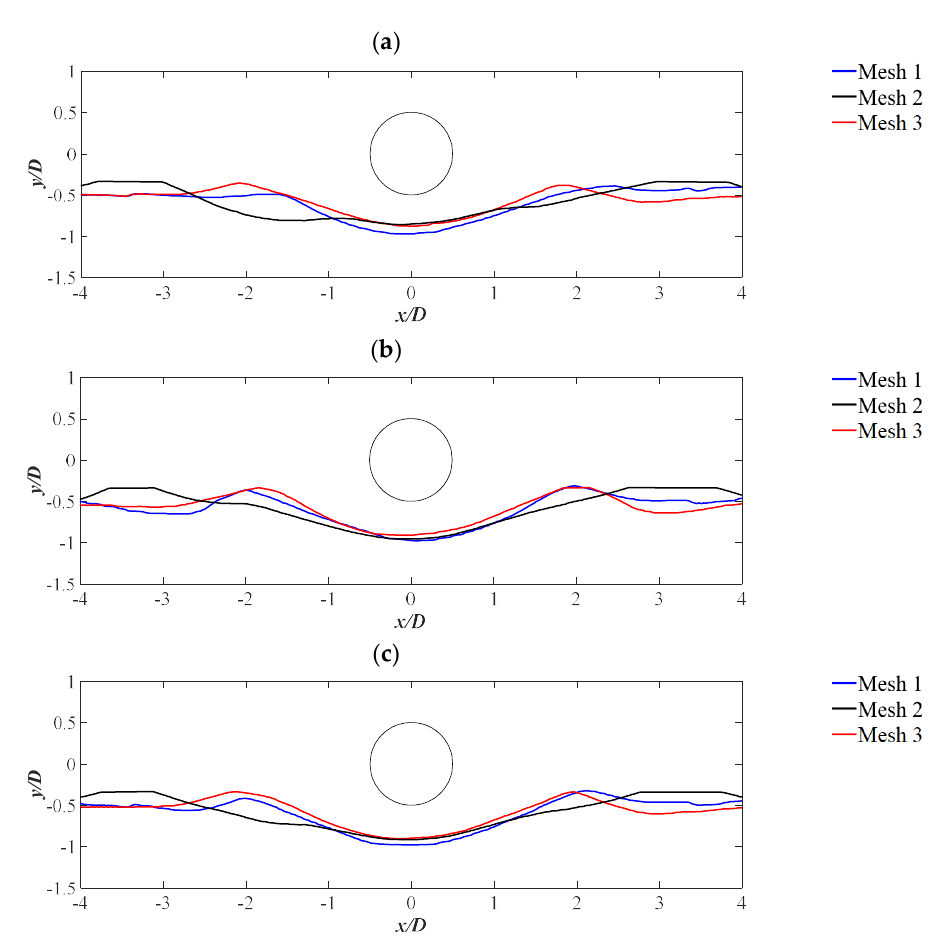
Figure 2. The sediment profiles denoted by φ = 0.5 for different meshes: Mesh 1: blue; Mesh 2: black; Mesh 3: red at ( a ) t = 70 s; ( b ) t = 90 s; ( c ) t = 110 s.